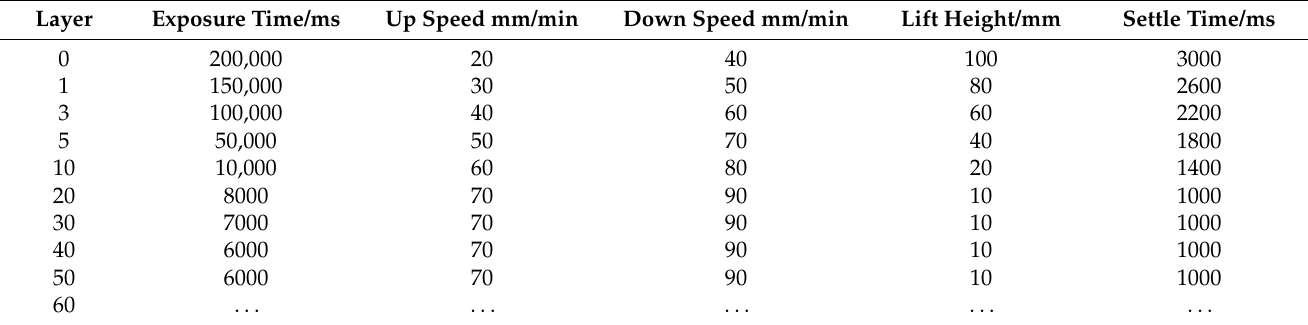
Table 3. Process parameters of light-curing 3D printing.